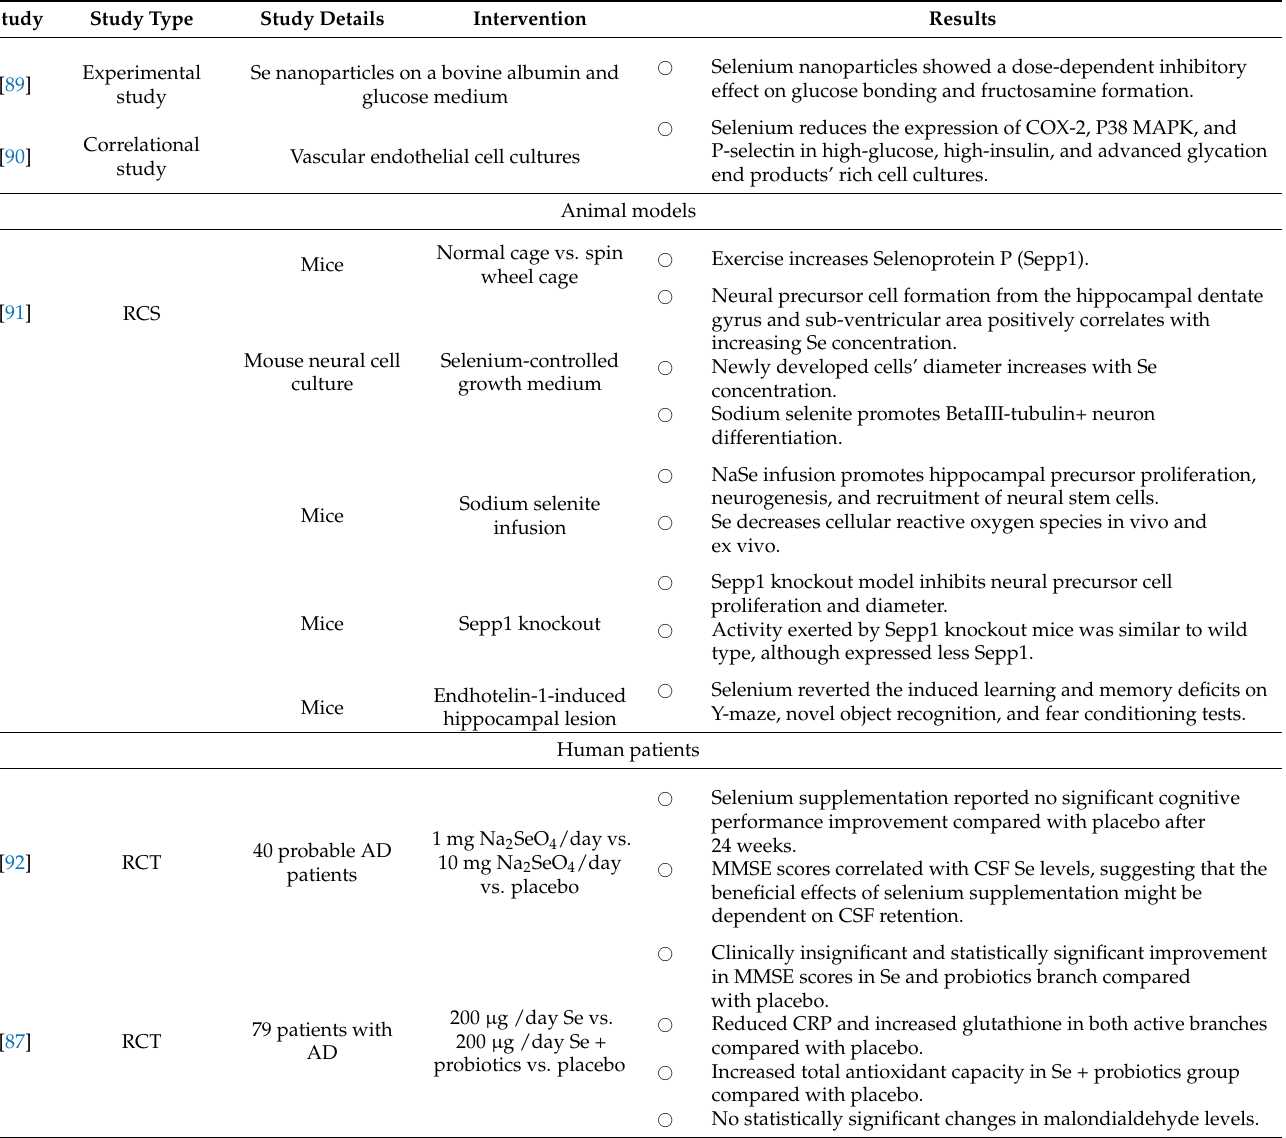
Table 3. The correlation between AD and selenium neuroprotective